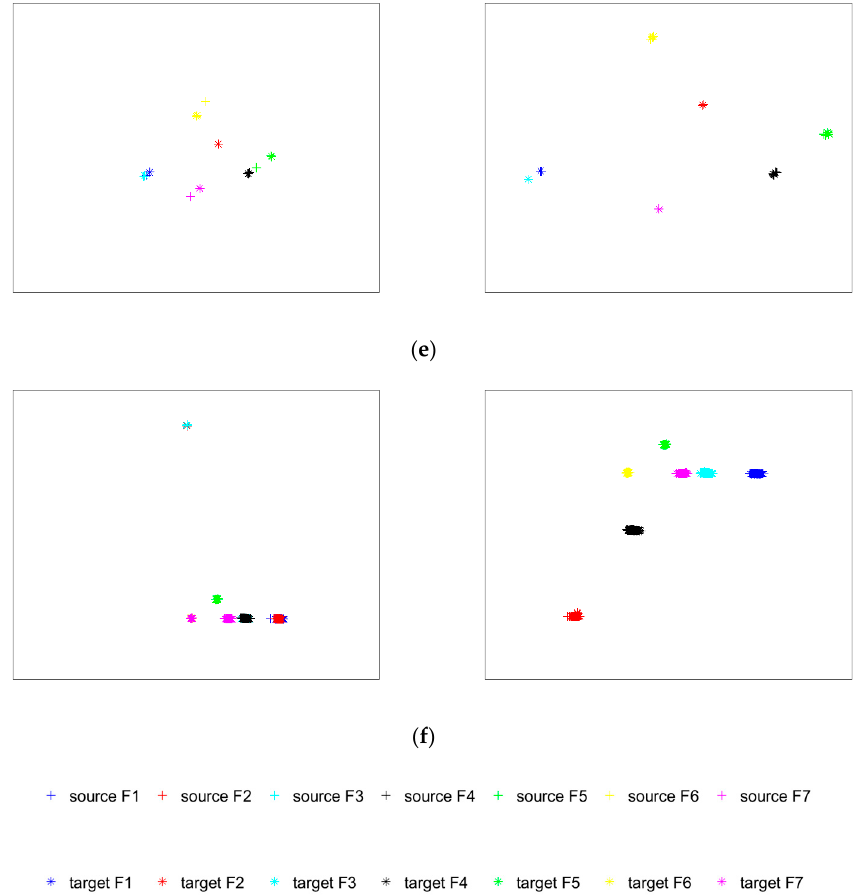
Figure 18. Visualization of fully connected layer transfer features: ( a ) transfer task A → B ; ( b ) transfer task A → C ; ( c ) transfer task A → D ; ( d ) transfer task B → C ; ( e ) transfer task B → D ; ( f ) transfer task C → D .